Question: What does this figure show? Answer in one sentence.
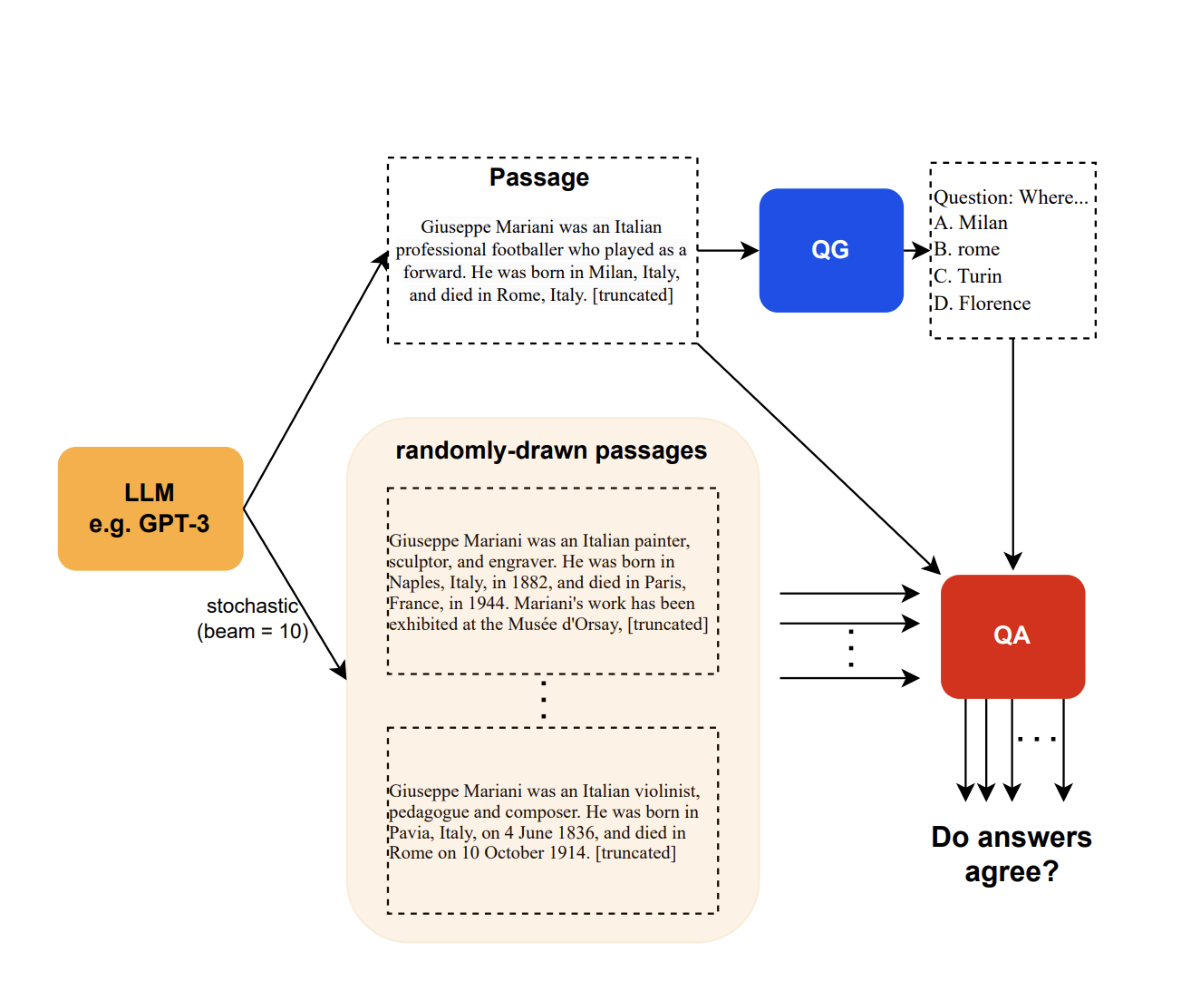
Answer: Illustrative diagram of the Self-Consistency approach, demonstrating the process of generating and evaluating multiple responses to ensure accuracy, adapted from [12]. This representation underscores the iterative nature of response generation and the subsequent analysis for consistency.